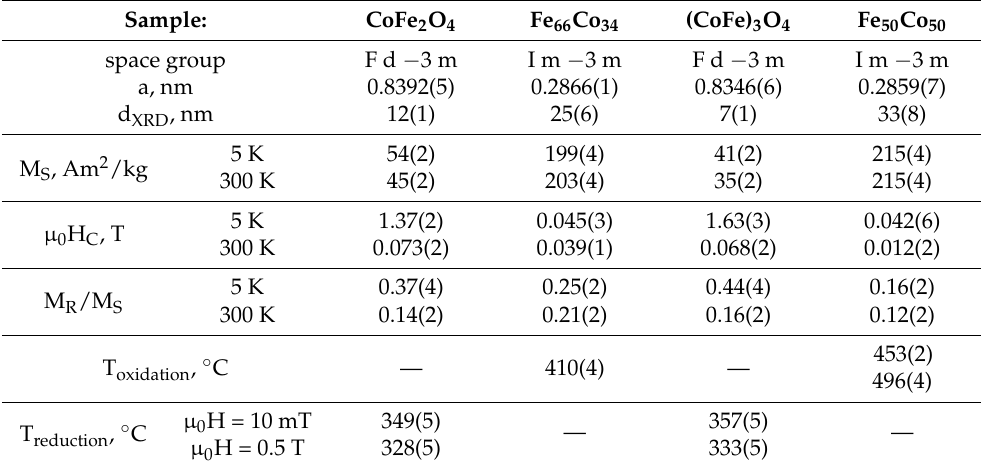
Figure 2. Field dependence of magnetization of oxide and metallic MNPs measured at ( a ) 5 K and ( b ) 300 K. Table 1. Structural and magnetic properties of Co-ferrite and corresponding FeCo metal MNPs. Uncertainties on the last digit are given in